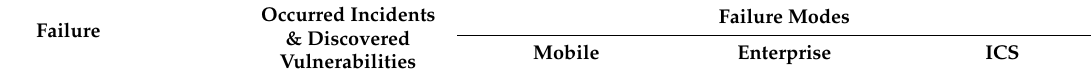
Table A2. Samples of failures, incidents and vulnerabilities, and failure